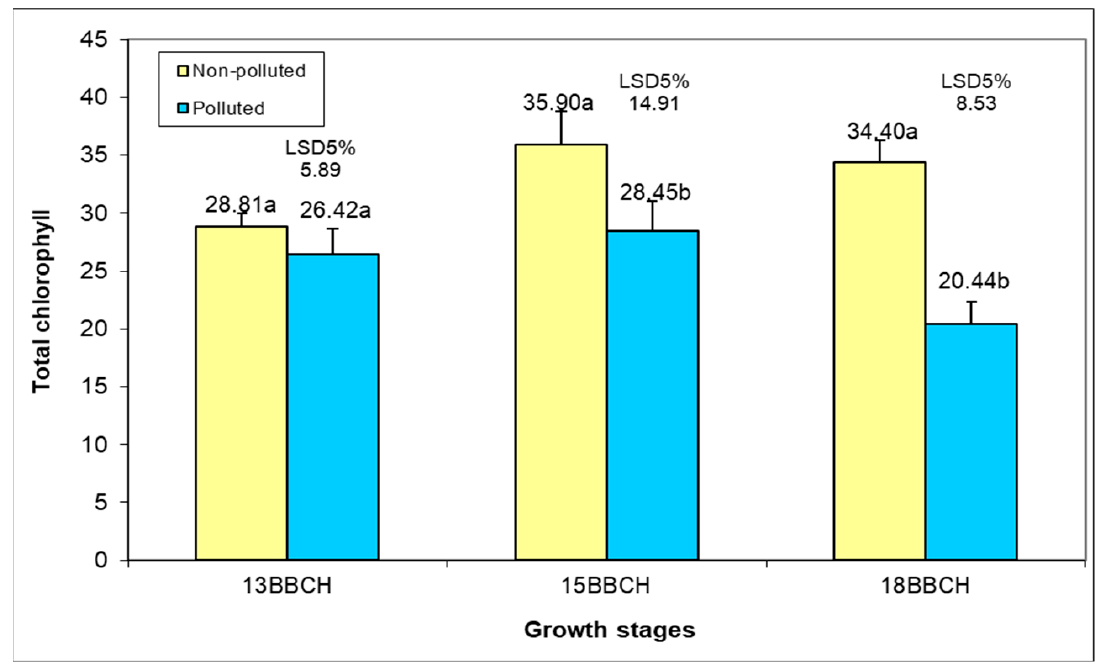
Figure 9. Total chlorophyll content ( μ g cm − 2 ) of S. perfoliatum for different growth stages in Ps and Us. Error bars represents SE. Different letters (a–b) indicate significant differences ( p < 0.05) between soils.